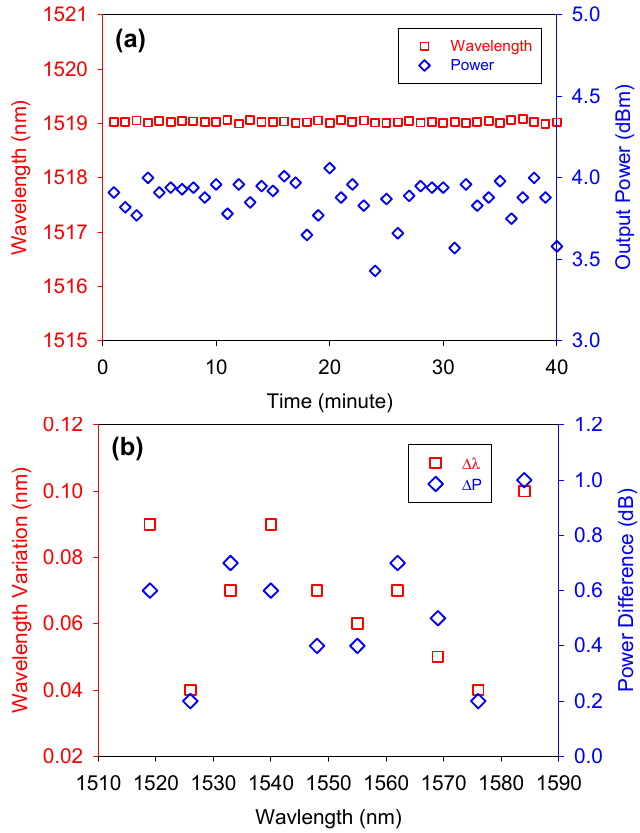
Figure 6. ( a ) Measured output power and wavelength variations of 1519.0 nm wavelength through 40 min observation. ( b ) Measured power and wavelength differences over a bandwidth from 1519.0 to 1584.0 nm.